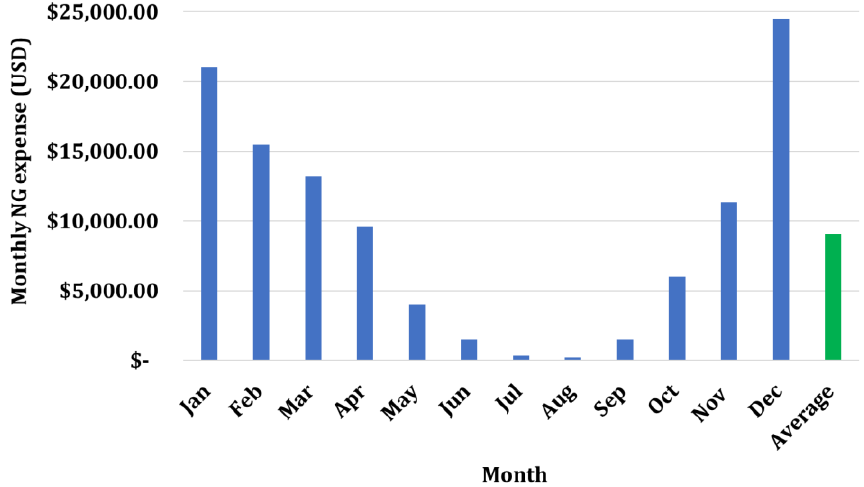
Figure 30. Monthly natural gas expense in Ontario to heat Greenhouse 3.